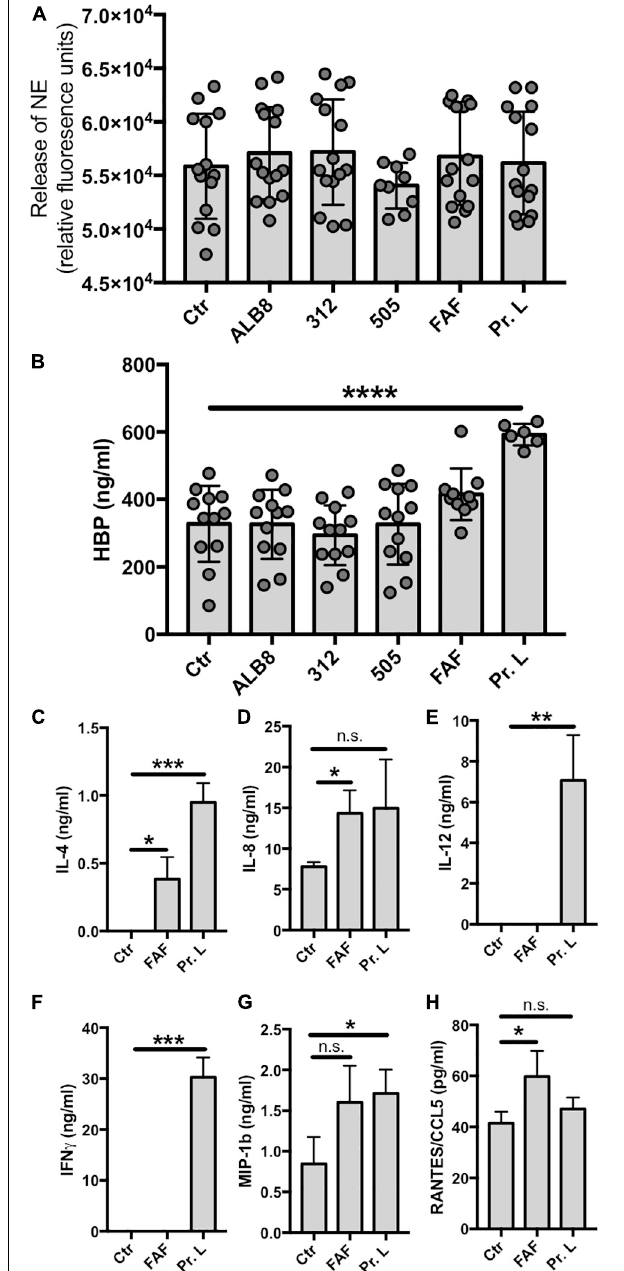
FIGURE 4 | Protein L triggers HBP and cytokine release. (A–H) Neutrophils were incubated with F. magna bacteria or their proteins for 2 h and supernatants were collected for (A) NE enzyme activity, (B) HPB release or (C–H) cytokine profiling. (A) Enzyme activity was measured using NE EnzChek assay kit. None of the used stimuli triggered enzyme activity. (B) Protein L significantly induced the release of HBP. Whole bacteria and protein F had no effect on the HBP release. (C–H) Cytokine profile was determined after co-incubation of neutrophils with F. magna -derived proteins FAF (3.8 µ g/ml) or protein L (3 µ g/ml) for 2 h. (C) IL-4, (D) IL-8, (E) IL-12, F) INF γ , (G) MIP-1b and (H) RANTES/CCL5. Data represent mean ± SEM of 3 independent experiments. * p ≤ 0.05, ** p ≤ 0.01, *** p ≤ 0.001, **** p ≤